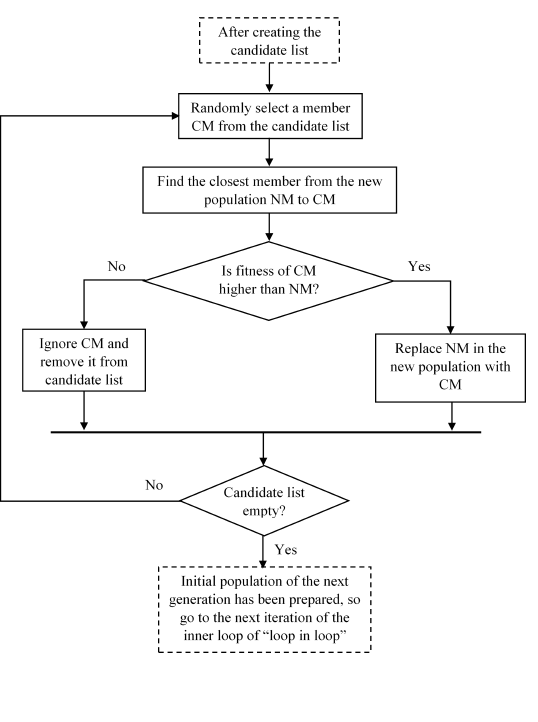
Figure 5: Forming the initial population of the next generation by selecting the most fitted members of the candidate list and the new